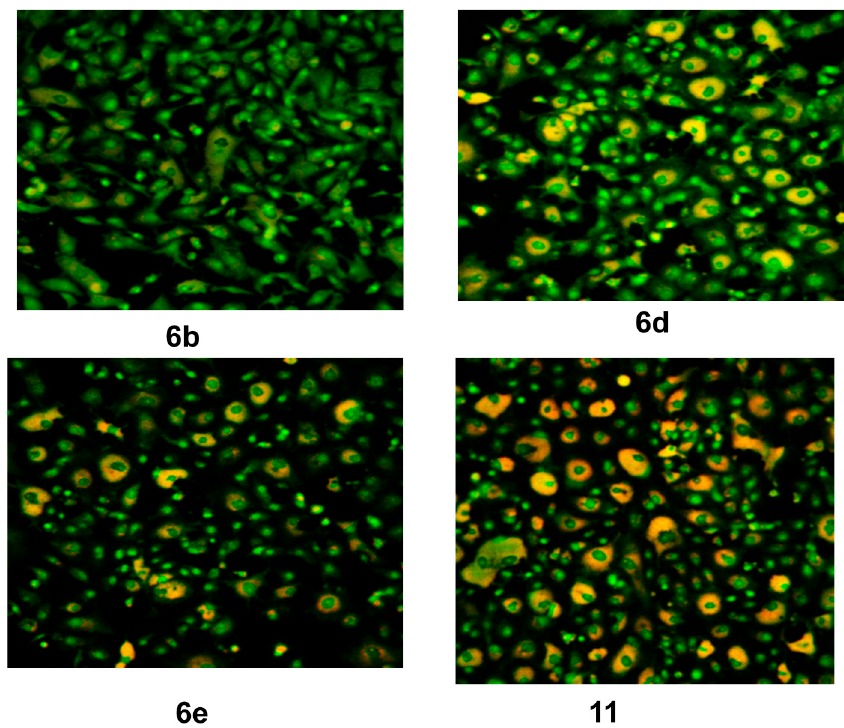
Figure 5. CLSM image of HEP G2 cell line treated with 0.6 µ M tested compounds ( 6b , 6d , 6e and 11 ). Stained by Acridine orange (green) and Rodamine 123 (Orange).